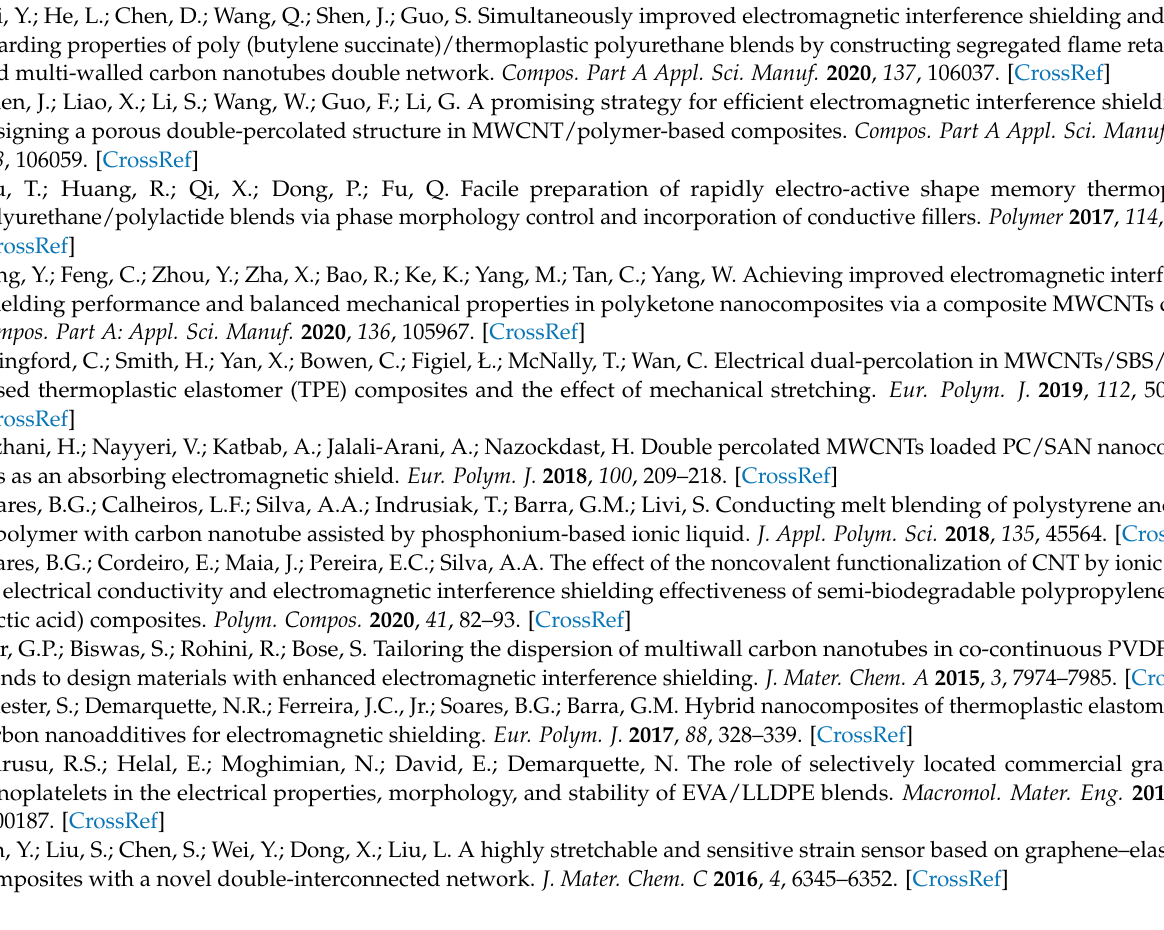
rheometer for pure PP and PS. Figure S2: Effect of treatments on electrical conductivity as a function of MWCNTs concentration for PP/MWCNTs composites. Figure S3: Image treatment analysis for distinguishing between two phases: (a) original SEM picture for PP/PS/MWCNTs composite with 0.3 wt.% of MWCNTs; (b) image phase separation; (c) final treated image which was used for the estimation of L int —interface length between two phases, which in this case is the perimeter of the white phase (PS phase). Table S1: Percolation threshold and fitting values of experimental data according to Equation (6) for PP/MWCNTs composites after each treatment. Figure S4: Electrical conductivity as a function of time for PP/MWCNTs composite with 0–0.3 wt.% of MWCNTs measured every 10 s at 1 Hz of frequency and 135 ◦ C. Figure S5: Electrical conductivity as a function of time